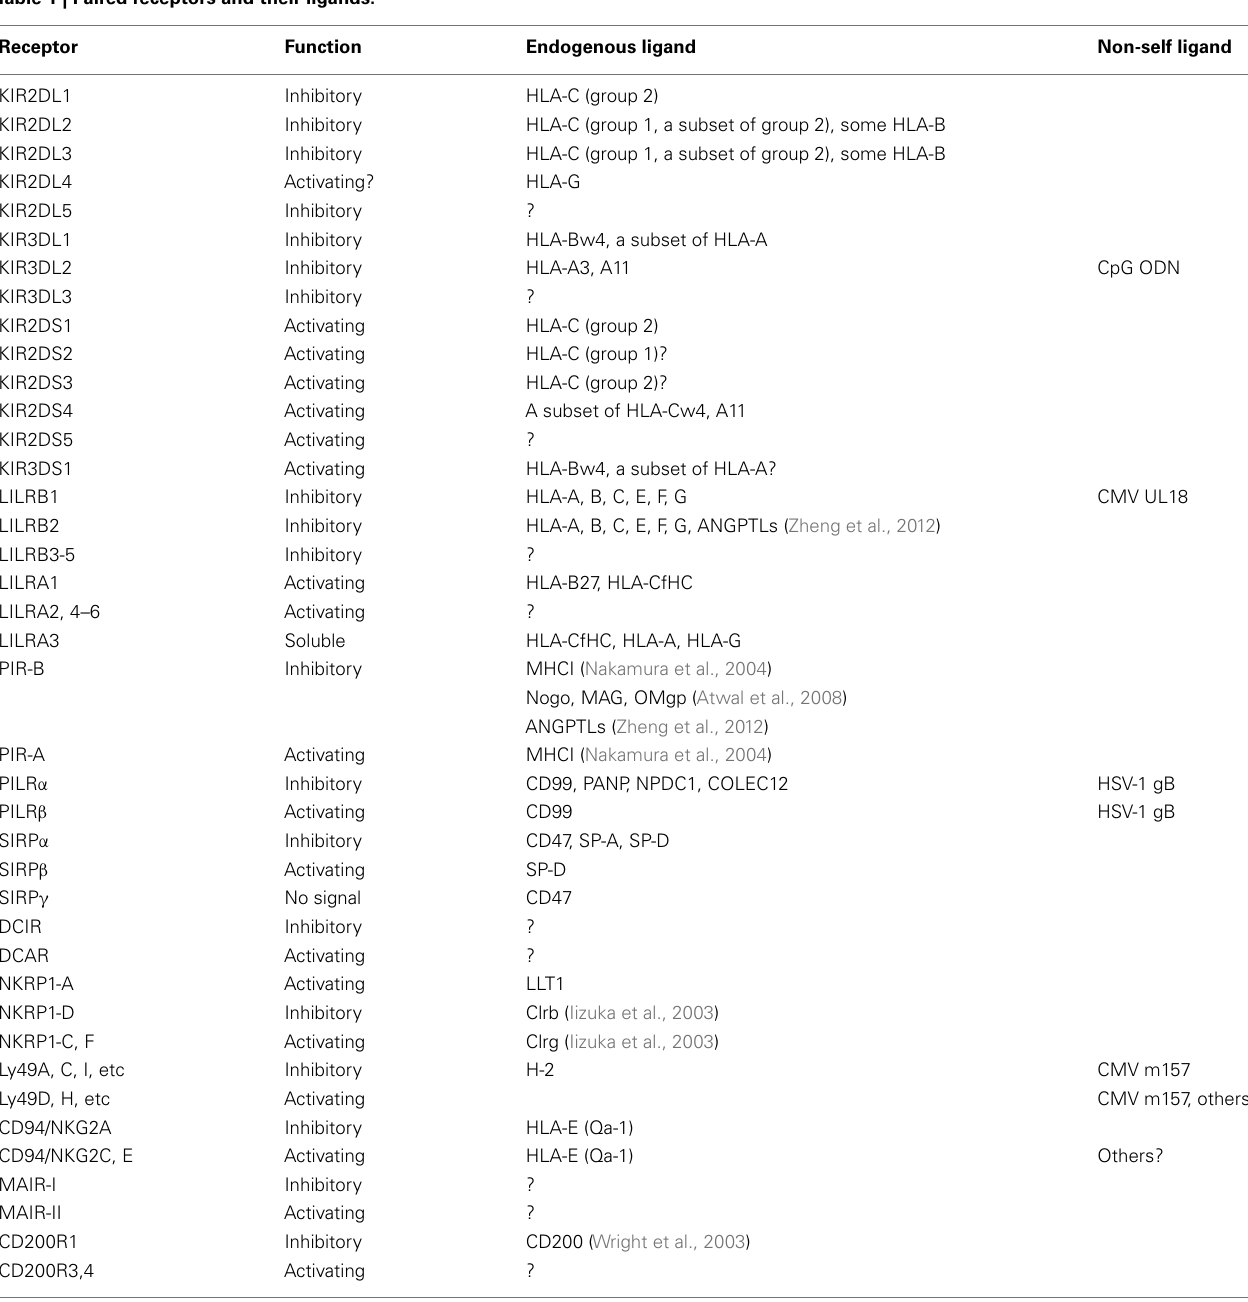
Table 1 | Paired receptors and their ligands. Receptor Function Endogenous ligand